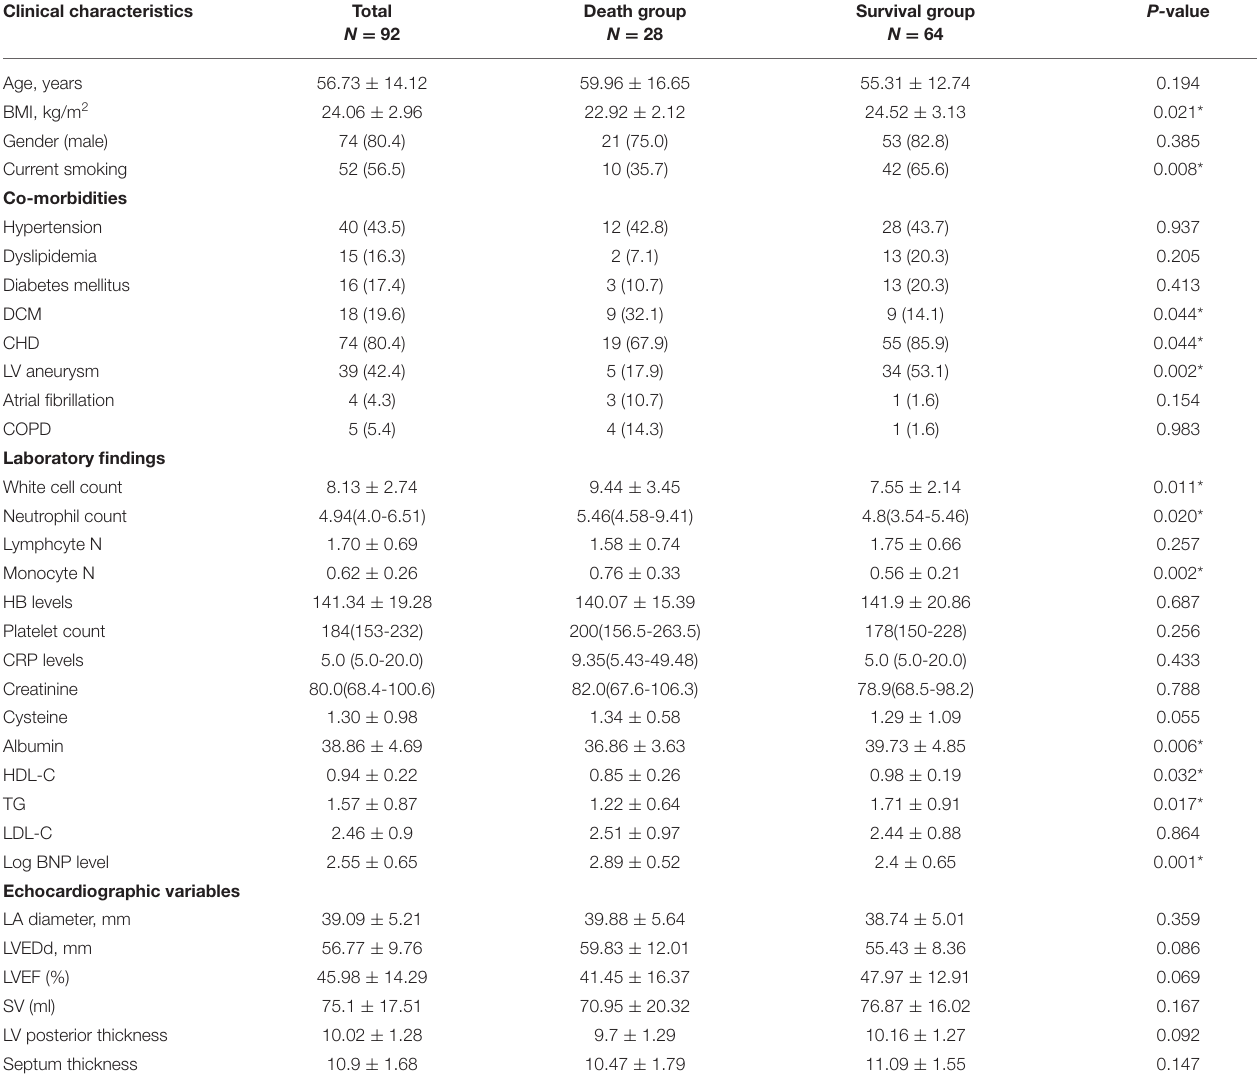
TABLE 1 | Baseline characteristics at admission of the LVT patients. Clinical